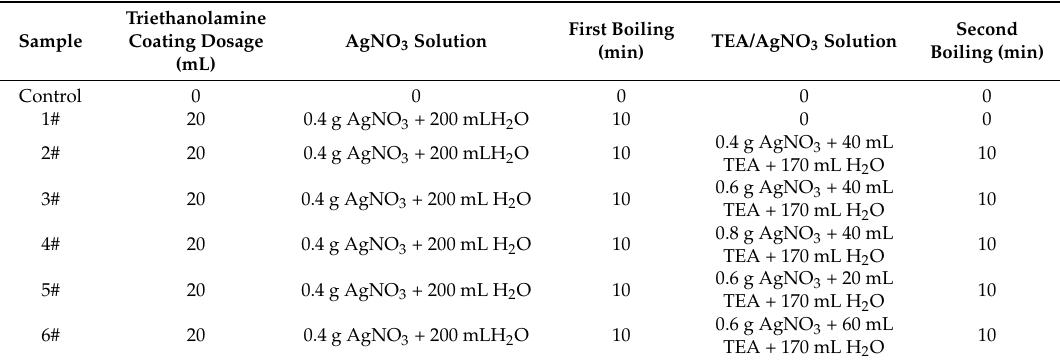
Figure 1. Schematic diagram of preparing Ag functionalized nonwoven polypropylene. Table 1. Sample preparation conditions.